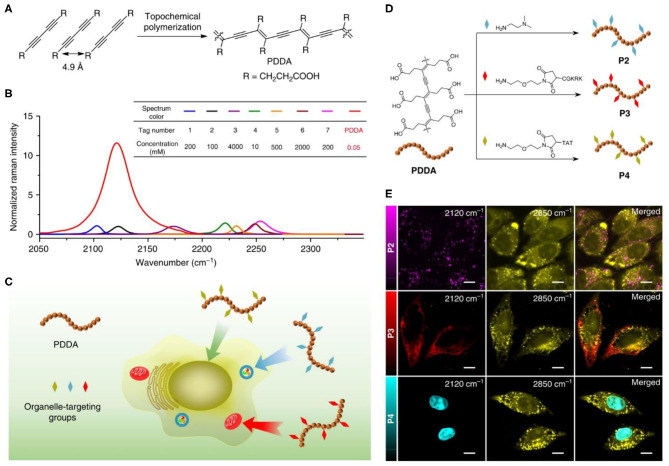
Polydiacetylene-based Raman probes for targeted live-cell Raman imaging. (A) Topochemical polymerization for the preparation of PDDA. (B) Overlaid Raman spectra of individual DMSO solution of PDDA and a series of representative Raman probes, including 1. ethynylbenzene; 2. 5-ethynyl-2′-deoxyuridine; 3. diphenyl phosphorazidate; 4. diphenylbutadiyne; 5. benzonitrile; 6. 5-bromopentanenitrile; 7.deca-4,6-diynedioic acid. (C) Schematic illustration of side chain modification of PDDA for subcellular organelle targeting Raman imaging. (D) Side chain modification of PDDA with different functional groups to derivatives P2, P3, and P4 that can be targeted to specific subcellular organelles. (E) Images of HeLa cells treated with 50 μM of P2, P3, and P4, respectively. Images shown from left to right are the alkyne (2,120 cm−1), lipids (2,850 cm−1), and merged images. Reprinted with permission from Tian et al. (2020). Copyright 2020, Nature.